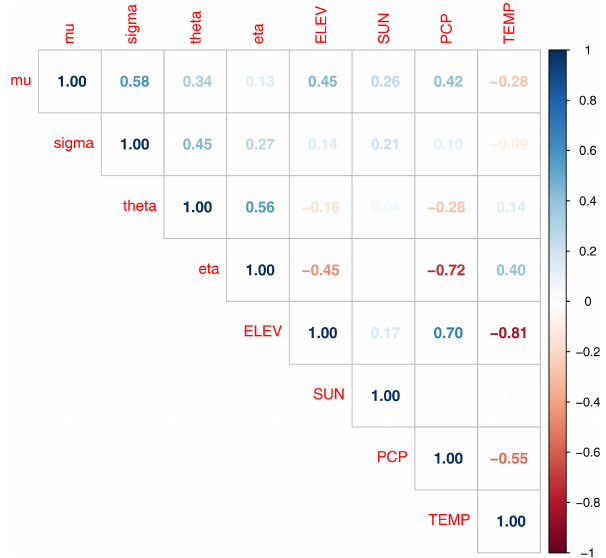
Figure A1. Cross-correlation between the selected local parameters (Koutsoyiannis and GEV parameters) for regionalisation and useful site characteristics that might act as an external drift information. µ (mu) is the GEV location parameter, σ (sigma) the GEV scale parameter, and θ (theta) and η (eta) the Koutsoyiannis parameters. ELEV is short for elevation information, SUN is short for long-term average of annual sunshine duration, PCP is short for long-term average of annual rainfall amount, and TEMP is short for the long-term average of annual mean temperature.